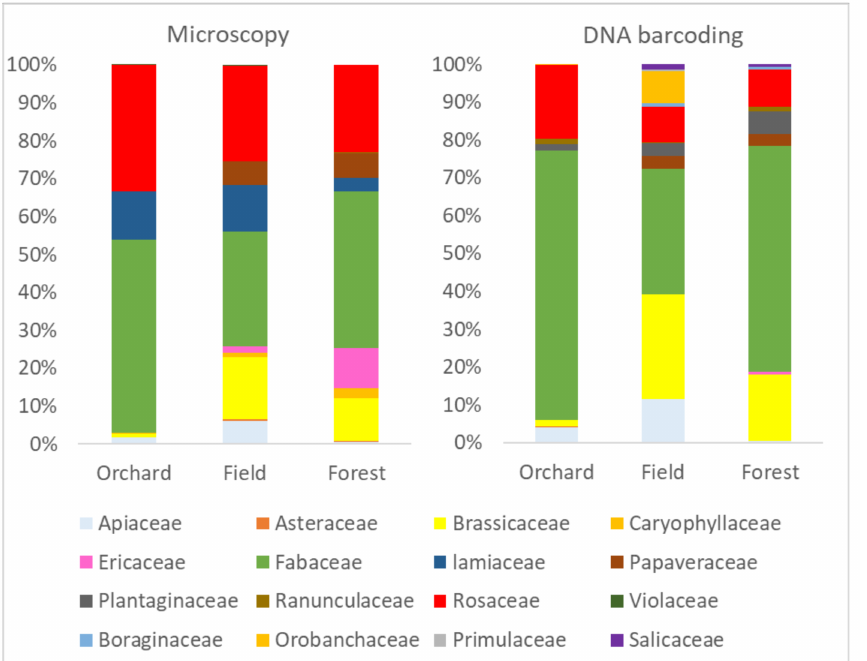
Figure 5. The percentage of bumble bee corbicular pollen loads containing the different number of plant